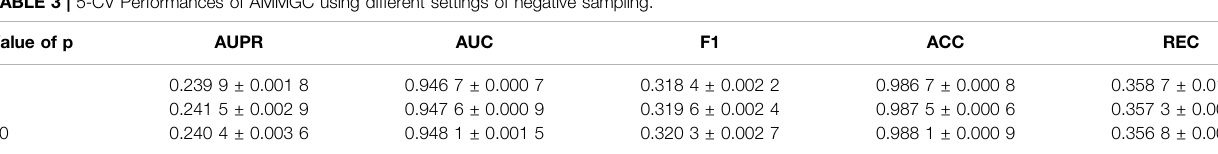
TABLE 3 | 5-CV Performances of AMMGC using different settings of negative sampling. Value of p